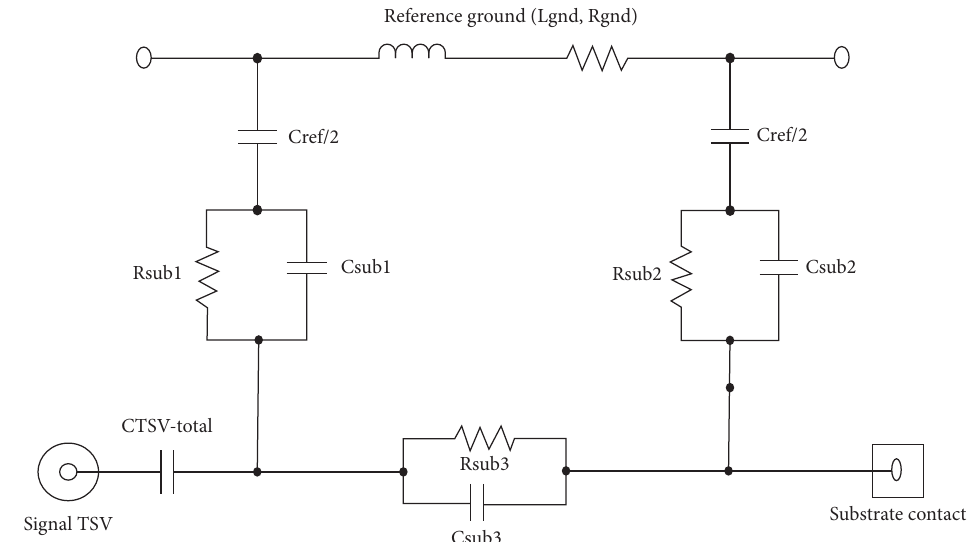
Figure 8: The equivalent circuit model of TSV-active circuit noise coupling.